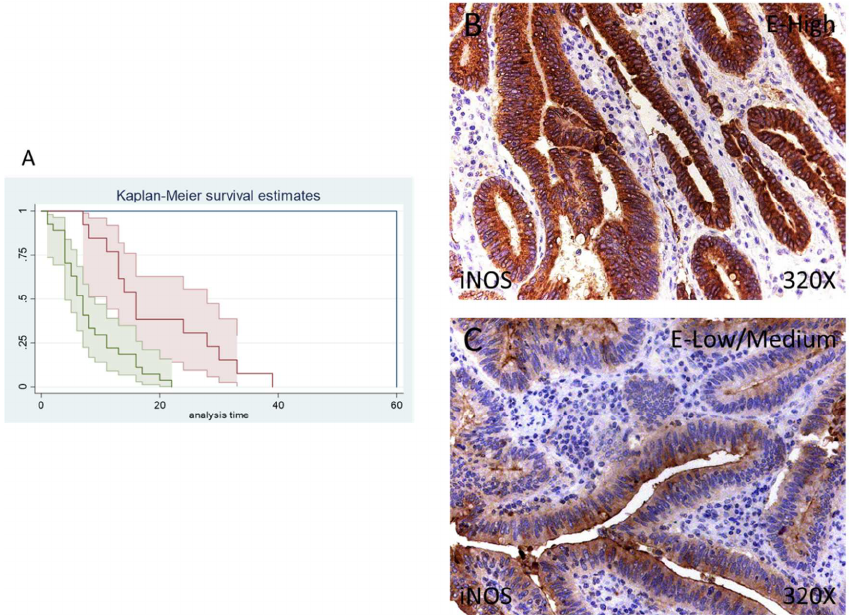
Figure 5. ( A ) Kaplan–Meier curves for survival time according to tumor expression of iNOS. Blue curve = tissue expression classified as negative, red curve = tissue expression classified as low/medium, green curve = tissue expression classified as high. ( B , C ) Images showing the protein expression of iNOS in patients diagnosed with pancreatic cancer.